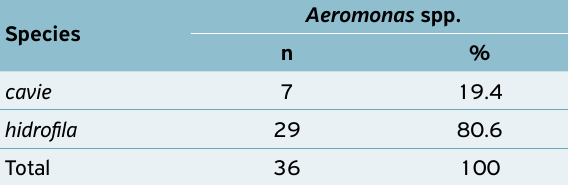
Table 3. Number and percentage of trahira samples ( H. malabaricus ) contaminated by A. cavie and A. hidrofila , São Bento, MA.